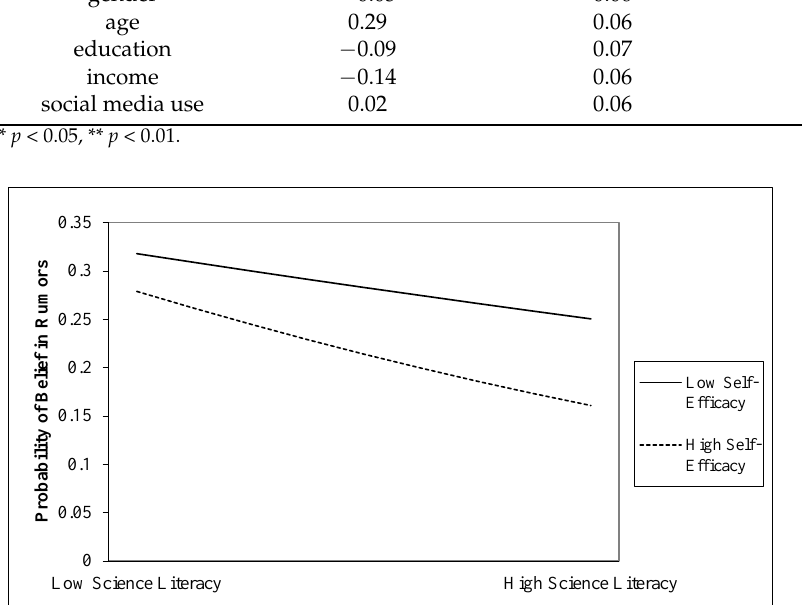
Figure 2. Interaction of science literacy and self-efficacy of science literacy.